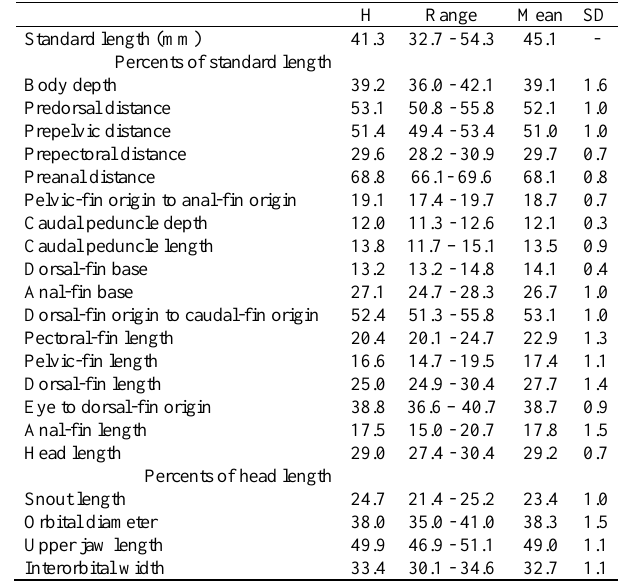
Fig. 2. Moenkhausia rubra , paratype, lateral view of left side of upper and lower jaws, LIRP 8178, 40.7 mm SL. Color in life. Overall background color ranging from yellowish to reddish, mainly on mid-dorsal area (Fig. 3). Midventral area silvery. Snout and gular area orange. Eye mostly orange, dorsal portion blue to green. Opercular region and circumbital bones silvery. Dark longitudinal stripe at mid-body. Humeral spot round and diffuse. Pectoral and pelvic fins hyaline. Anal and dorsal fins with unbranched and first to third branched anteriormost rays with dark marks. Dorsal, adipose, and caudal Table 1. Morphometric data of holotype (H) and paratypes of Moenkhausia rubra from Mato Grosso, upper rio Juruena, rio Tapajós drainage (n = 28). SD = standard deviation.